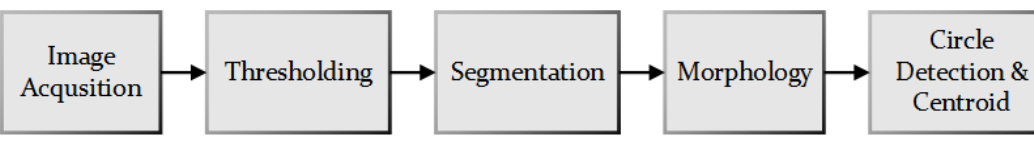
Figure 3. Blob tracking: Image processing